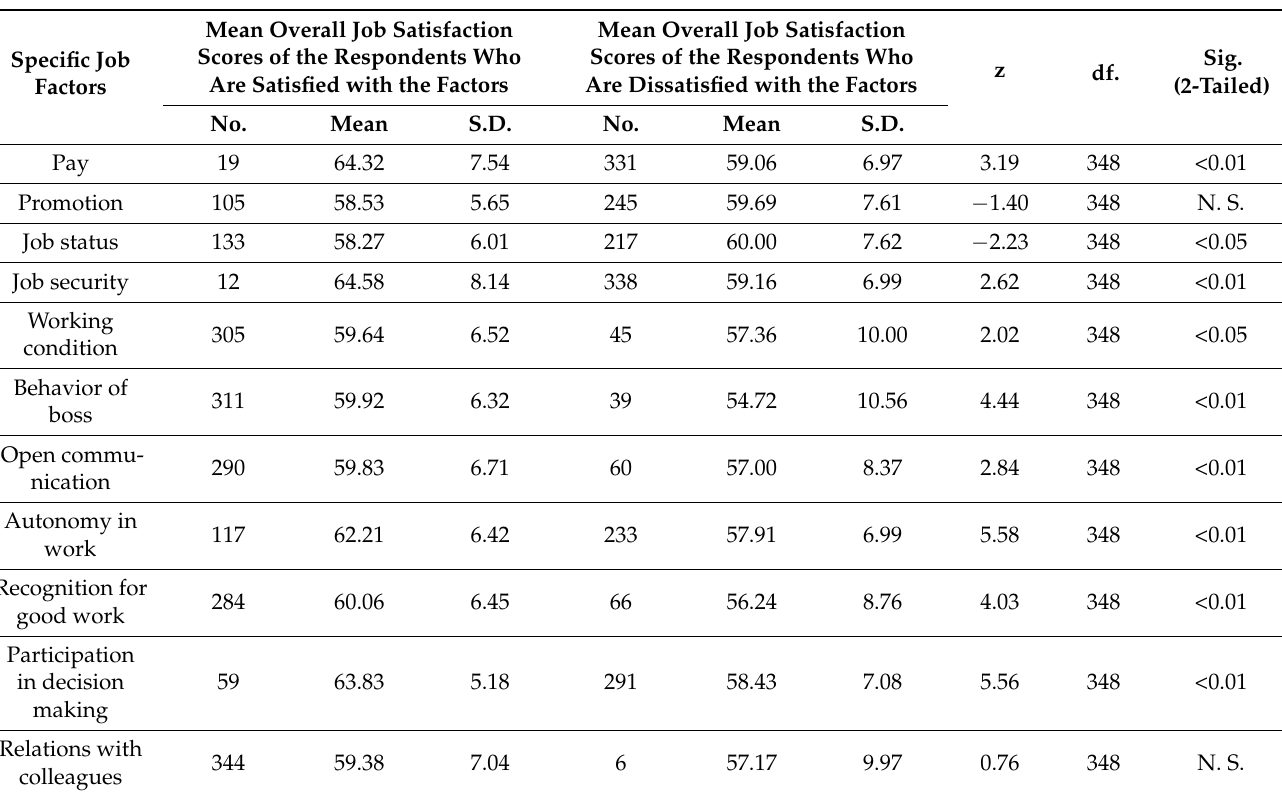
Table 4. Mean difference in job satisfaction according to the degree of satisfaction and dissatisfaction with some of the specific professional aspects (N =